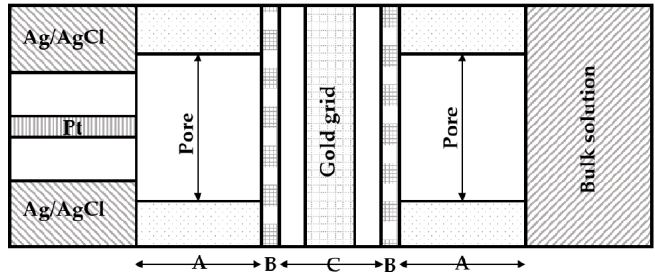
Figure 2. Microscopic cross-section of the permeable thin layer cell. The membrane control electrode assembly is comprised of three unique layers: polycarbonate membrane (A), cellulose acetate membrane (B), and the enzyme thin layer containing the gold grid and entrapped galactose oxidase (C).